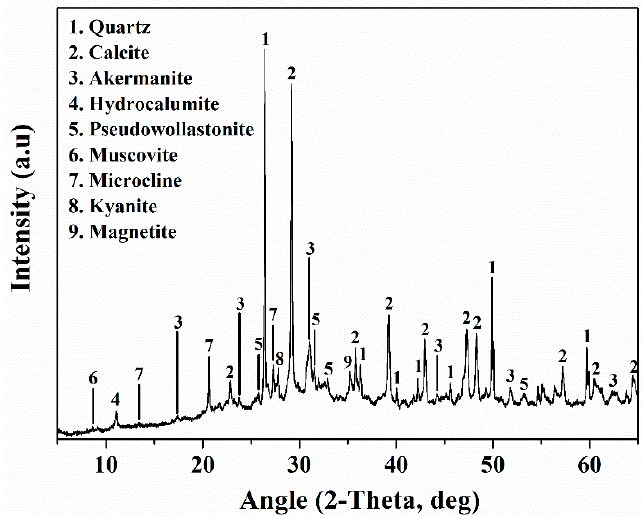
Figure 2. XRD pattern of WBA.